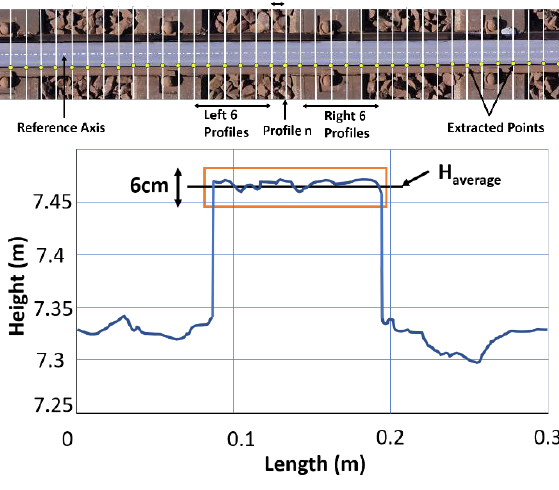
Fig. 4: upper: simulated cuts at a distance of 5 cm each, averaging over 6 profiles, reference axis, lower: profile